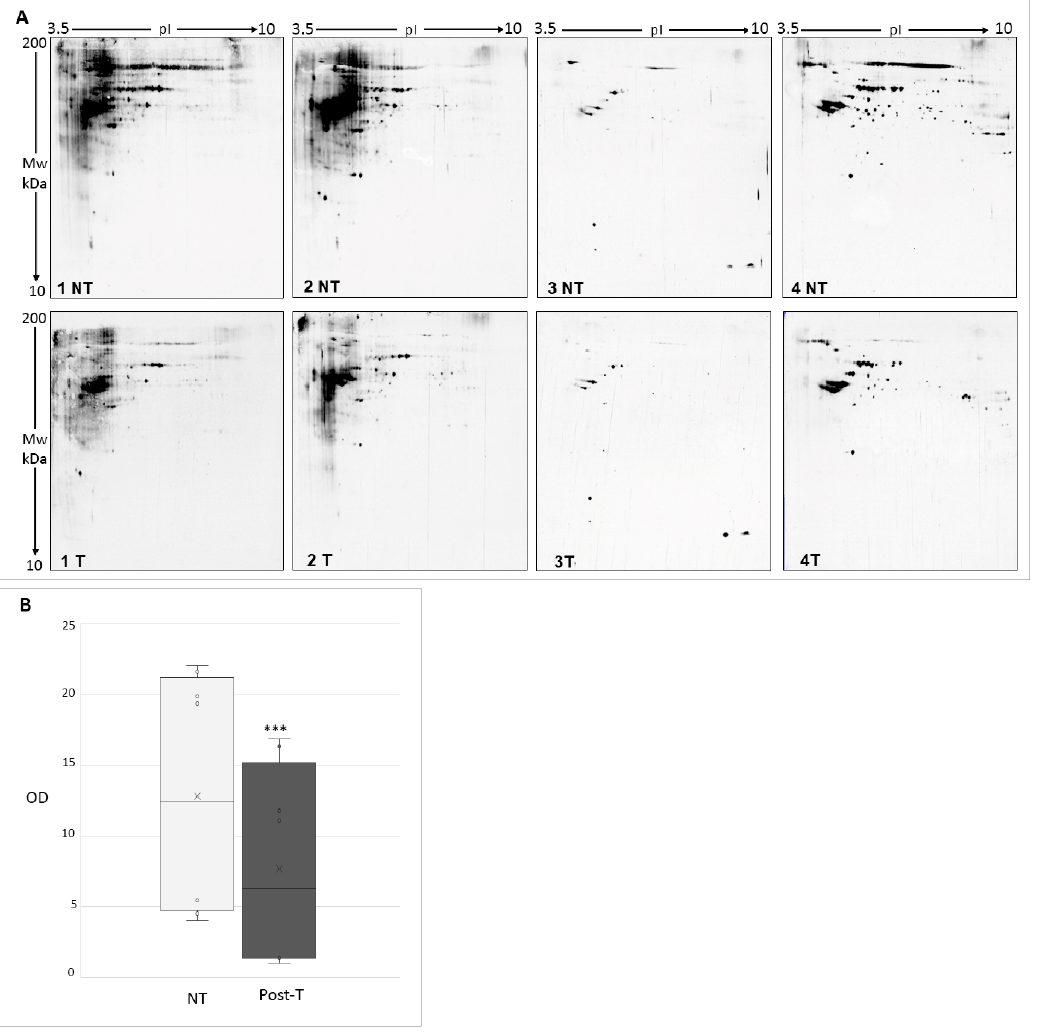
Figure 5. ( A ) Western blotting after two dimensional electrophoresis showing carbonyl groups in untreated (NT) and in the corresponding treated (Post-T) sample. Four sperm samples were analysed. ( B ) Computer-assisted semiquantitative analysis of the overall relative intensity of the carbonyl groups in NT and in the corresponding Post-T sample. Carbonyl groups intensity was measured (pixel/mm 2 ). The graph highlights the significant decrease in carbonyl groups in Post-T samples. OD, optical density. Values are expressed as a mean (standard deviation). *** p < 0.01.